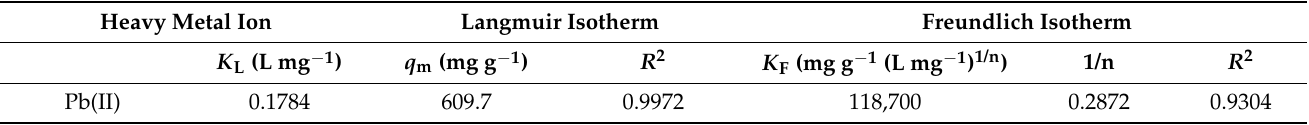
Table 2. Isothermal parameters and correlation coefficient fitted by Langmuir and Freundlich